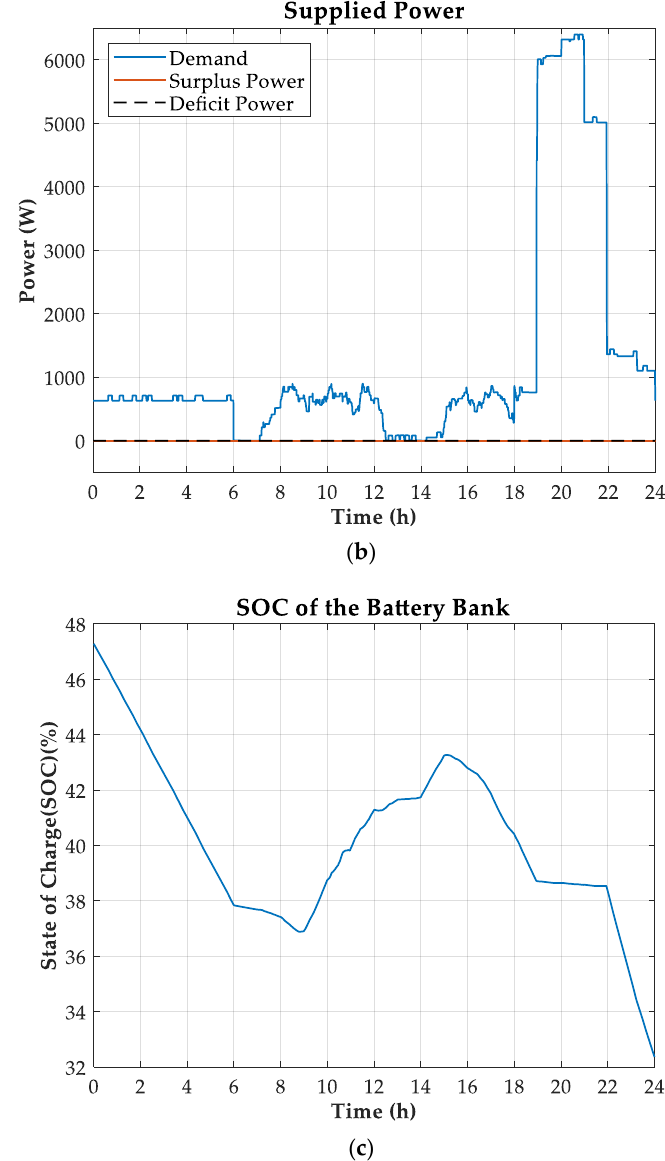
Figure 13. Results of the simulation of the PV / diesel / battery system. ( a ) Generated power; ( b ) supplied power; and ( c ) state of charge of the battery bank on June 2.